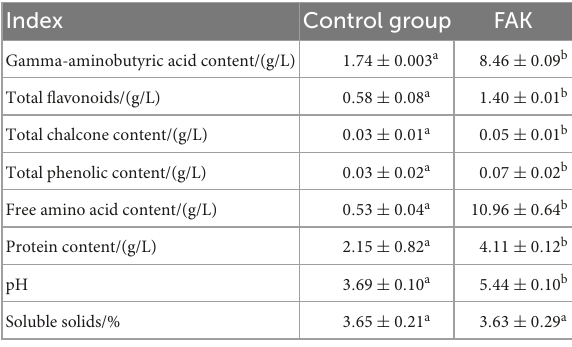
TABLE 1 Analysis of chemical ingredients composition of